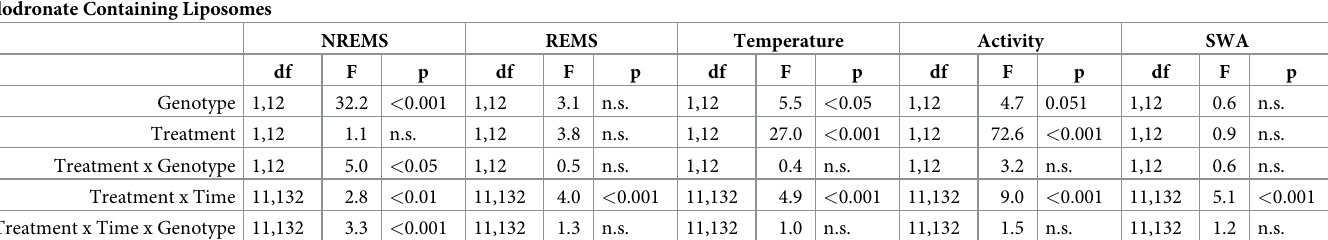
Table 3. Non-rapid-eye movement sleep (NREMS), rapid-eye movement sleep (REMS), body temperature, motor activity and electroencephalographic slow-wave activity (SWA) after CCL administration: Statistical results. Clodronate Containing Liposomes